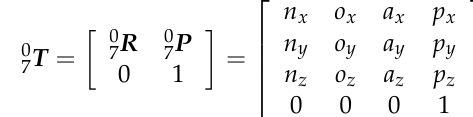
Figure 3. Planar four-bar mechanism.